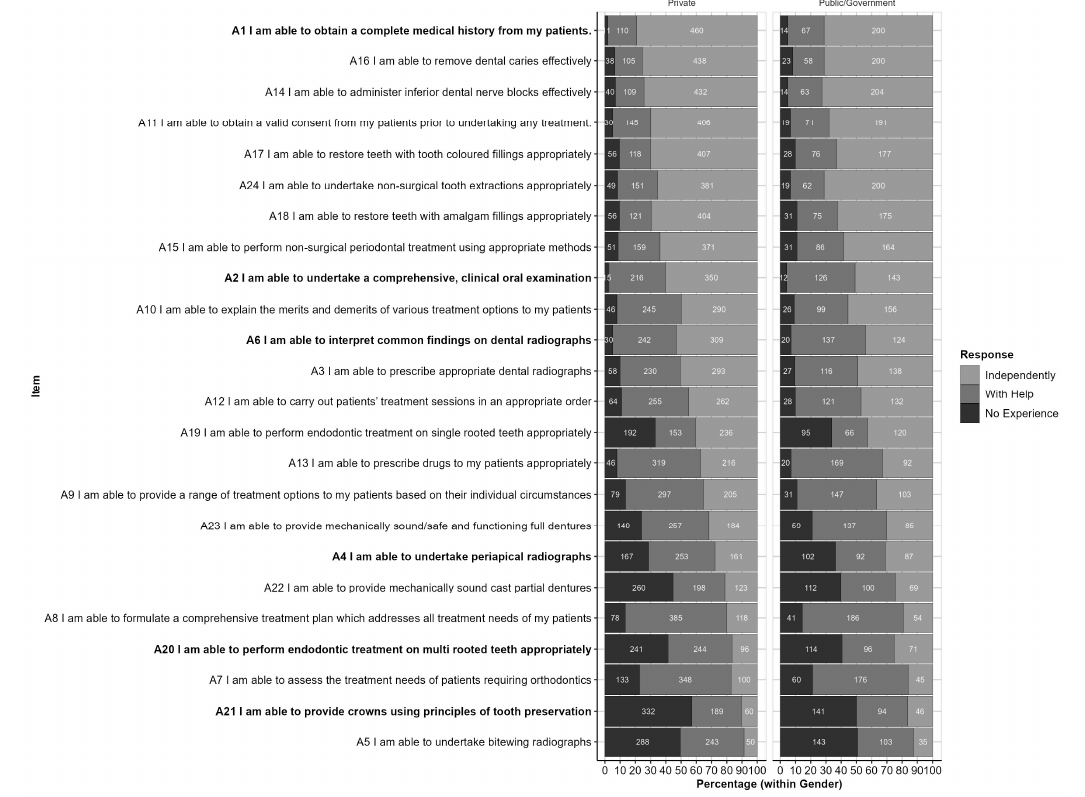
Figure 3. Responses by Part A items (within Institution Category); Responses are ordered from highest to lowest proportion of ‘Independent’ responses (across Institution Categories). Items for which response profiles differ by Institution Category ( p < 0.05) are highlighted in bold text. Table 3. Association between Institution Type and Item Responses for Part A. Specific p -values from Chi-Squared tests of association for items showing a statistically significant association be- tween Institution Type and Item Responses for Part A.